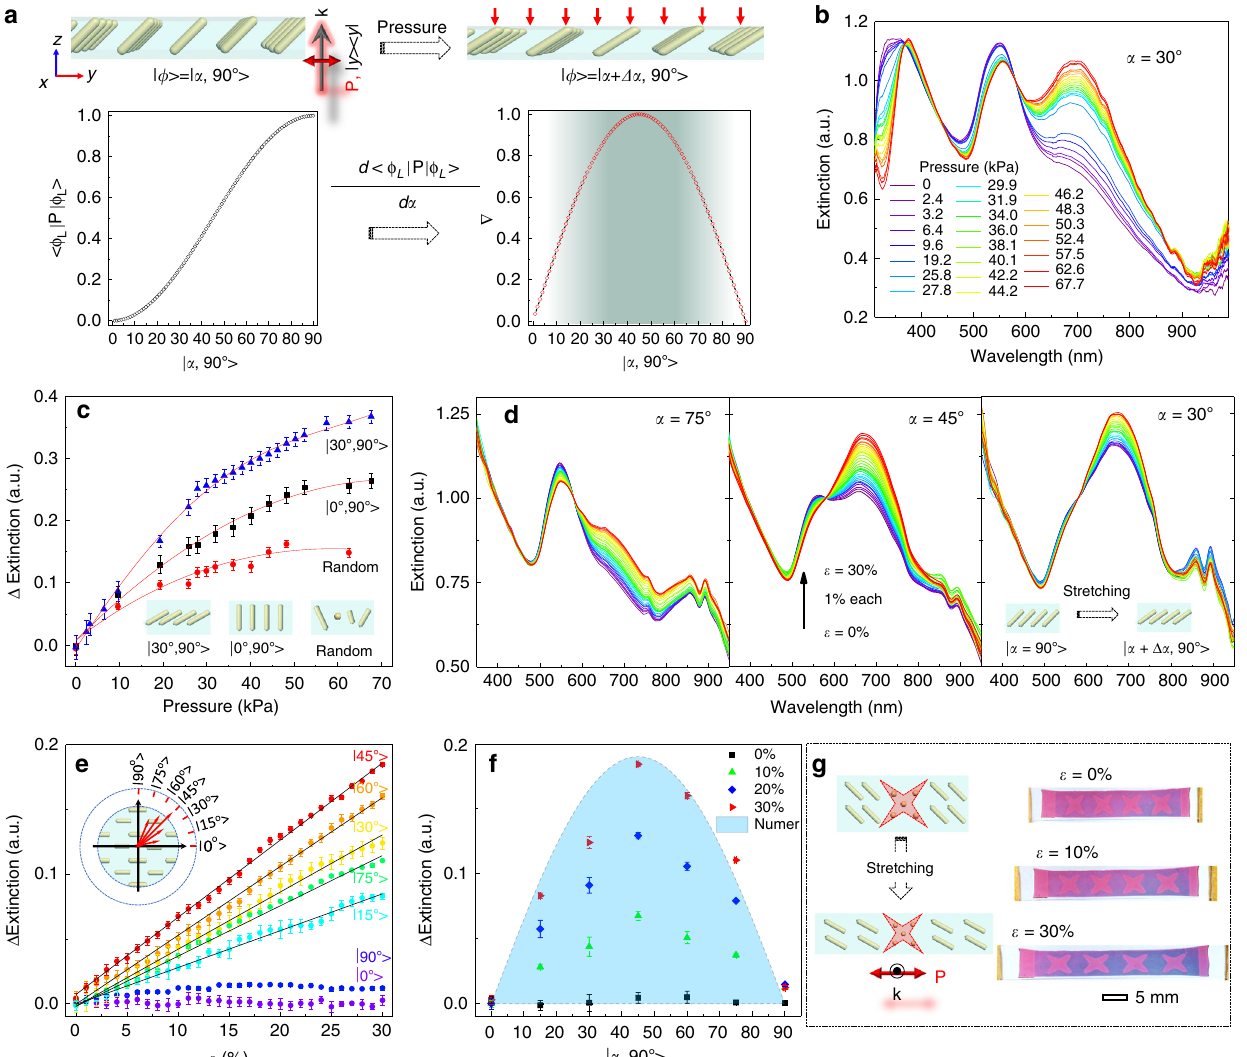
Fig. 3 Programming the mechanochromic response by magnetic alignment. a The design principles of mechanochromic response of plasmonic fi lms upon pressing and stretching. b Extinction spectra of the plasmonic fi lms under different pressures with cAuNRs aligned along 30 o to the surface normal. c Intensity changes of longitudinal modes when the plasmonic fi lms were subject to different pressures. Insets: cross-section view of the plasmonic fi lms. d Extinction spectra of the plasmonic fi lms under different strains with cAuNRs aligned along 75 o (left panel), 45 o (middle panel), and 30 o (right panel) to the stretching direction. Spectra were measured as strain ( ε ) increased from 0% to 30% with a step of 1%. Insets: top view of the plasmonic fi lms during stretching. e Summary of intensity changes of cAuNRs under different strains. Arrows in the inset indicate the slopes of the mechanochromic response. f Anisotropic mechanochromic response of the plasmonic fi lms enabled by magnetic alignment. The abbreviation, Numer, indicates the numerical results. g Orientation-dependent mechanochromic response of plasmonic fi lms enabled by magnetically aligning cAuNRs along pre-designated directions. The top view of the plasmonic fi lm is illustrated in the left panel to show the alignment of cAuNRs. Error bars in c and e represent the standard deviations from three experimental